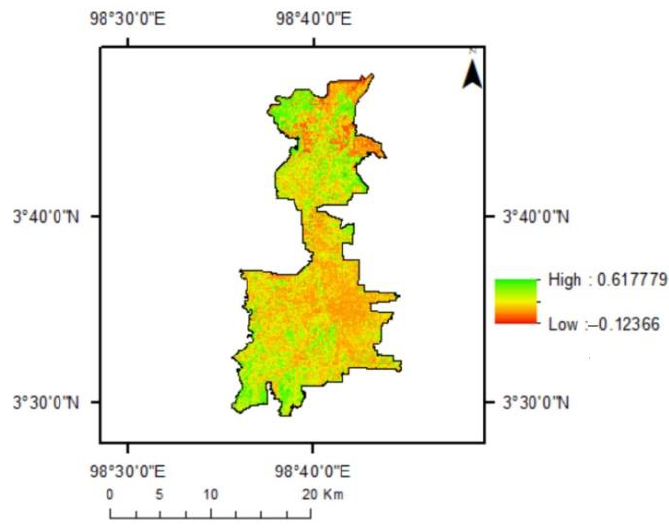
Figure 2. Map of NDVI Distribution in Medan City in 2019. Negative values correspond to locations with water, marshy surfaces, artificial struc- tures, rocks, and clouds; bare soil often produces values between 0.1 and 0.2, whereas plants consistently have positive values between 0.2 and 1. The values are more than 0.5 for healthy, dense vegetation canopy, while the values range from 0.2 to 0.5 for sparse vegeta- tion. NDVI readings are typically between 0.2 and 0.4 for places with minimal vegetation and 0.4 to 0.6 for areas with moderate vegetation, with anything above 0.6 indicating the highest potential green density [27]. The highest NDVI value in Medan was 0.618. A high value indicates the presence of high vegetation density. Some areas have negative values found in the field as watery areas in mangroves, paddy fields, and fishponds. The NDVI values in the year 2019 are depicted in Figure 3. Over 50% of the region had values less than 0.2. The fraction of locations with higher NDVI values decreased. Only 1.61 percent of the area had NDVI values greater than 0.5. This suggests that the majority of areas were devoid of vegetation.